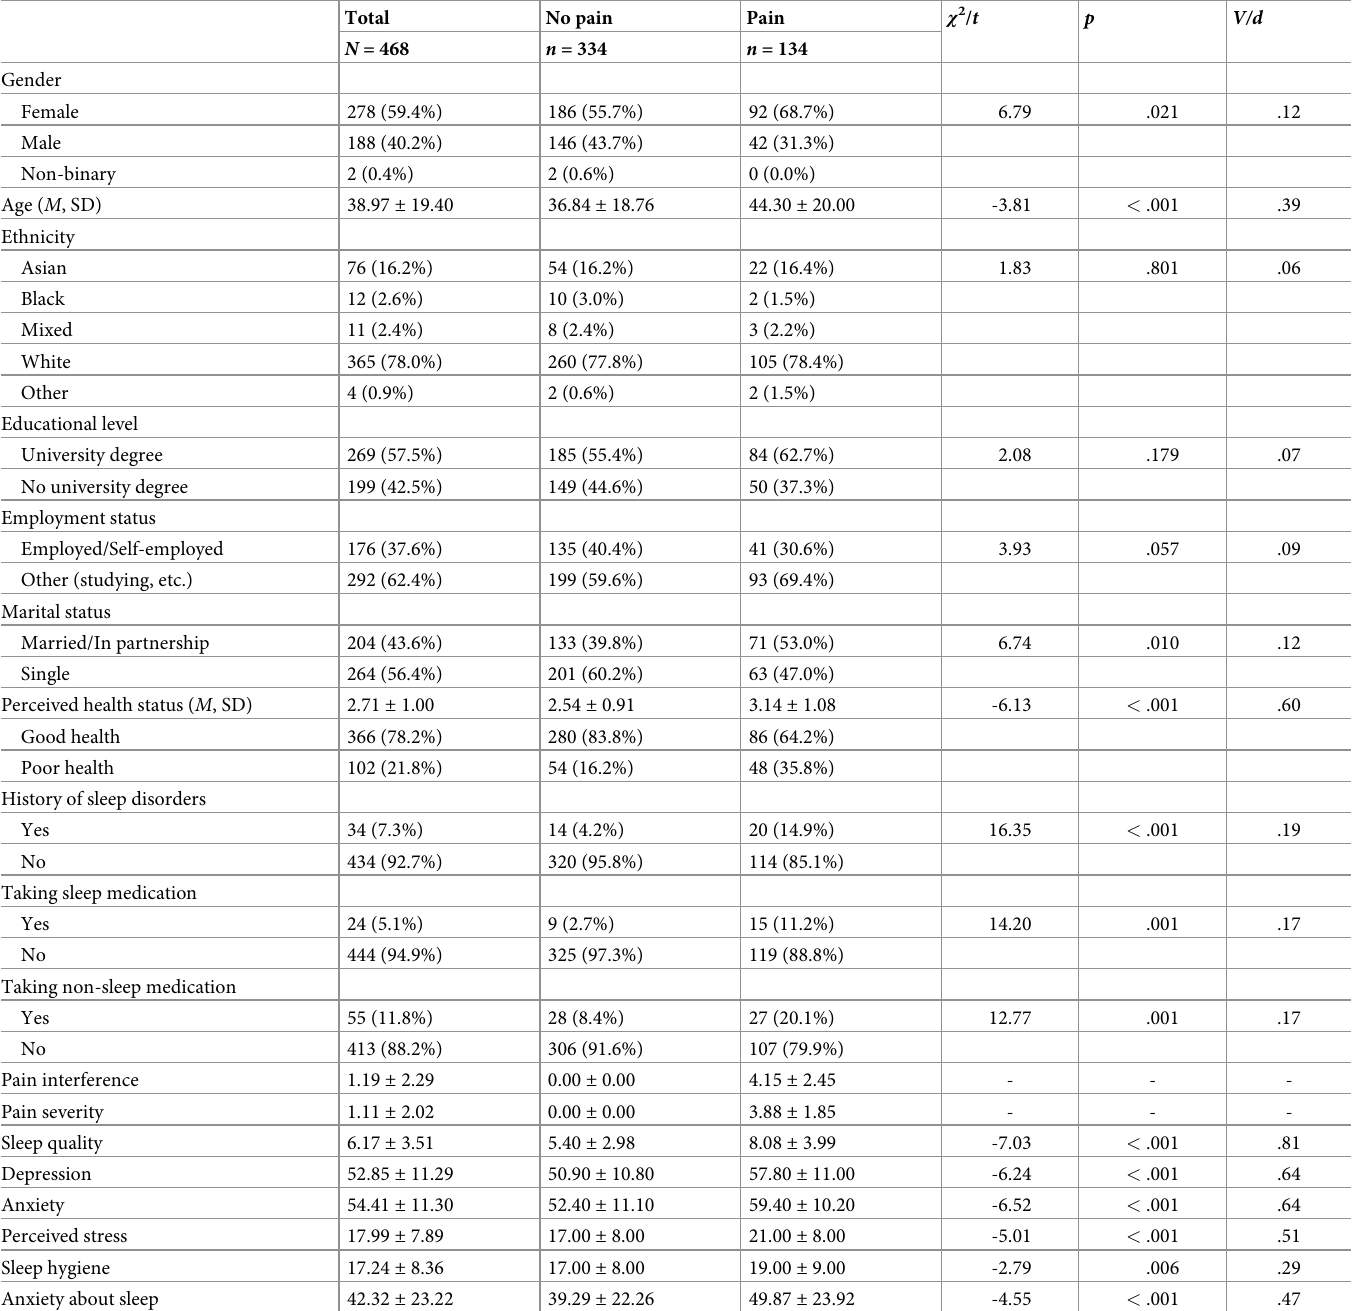
Table 1. Participant characteristics and descriptive statistics of the study